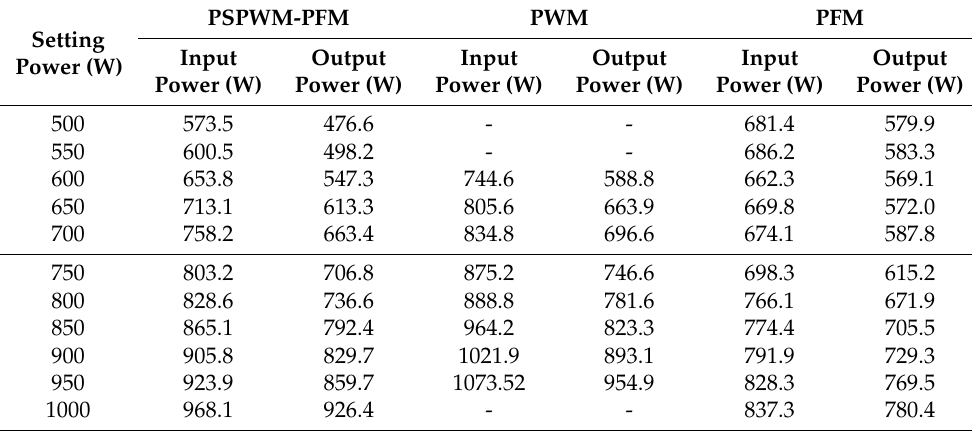
Table 4. Algorithm performance test data table.